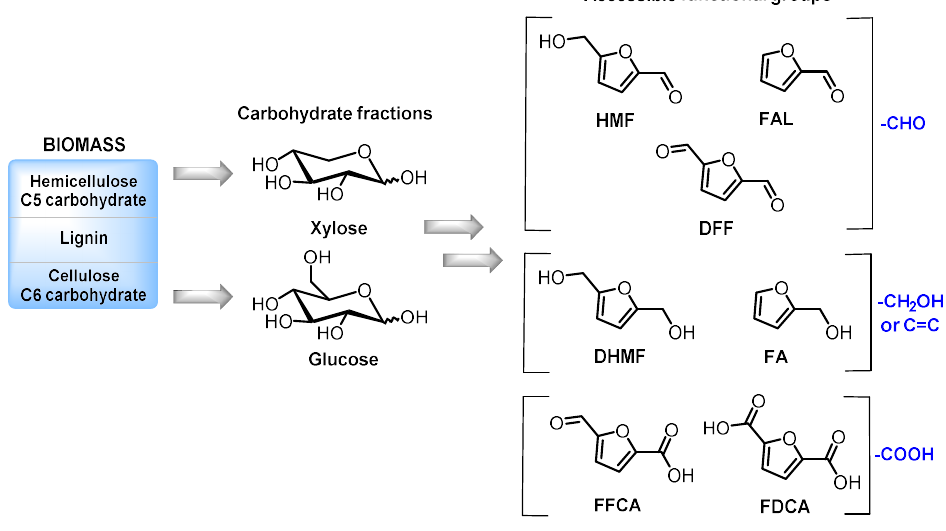
Figure 1. Examples of furanic substrates and target functionalities.